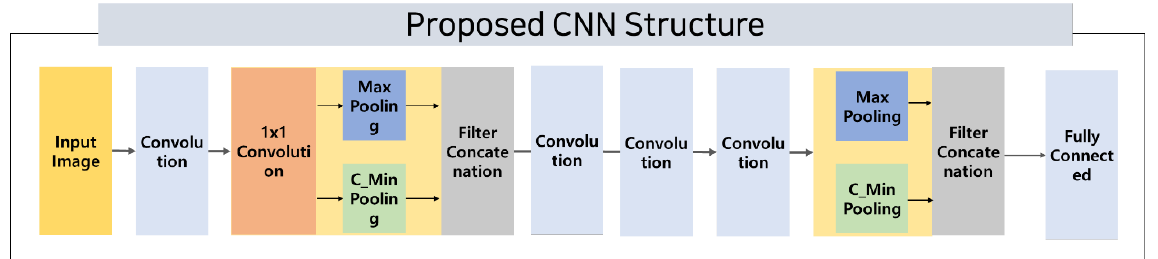
Figure 4. Structure of proposed restructured CNN. Table 1. Detail structure of proposed restructured CNN.